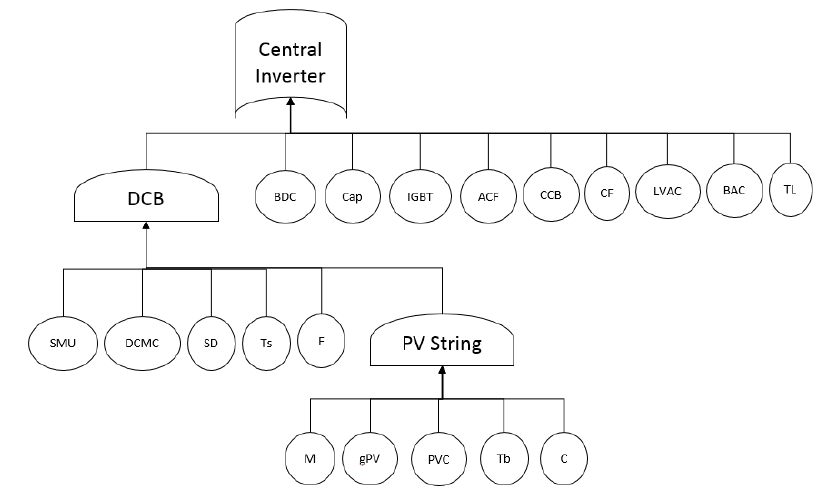
Figure 2. Fault tree of the CI (DC side).